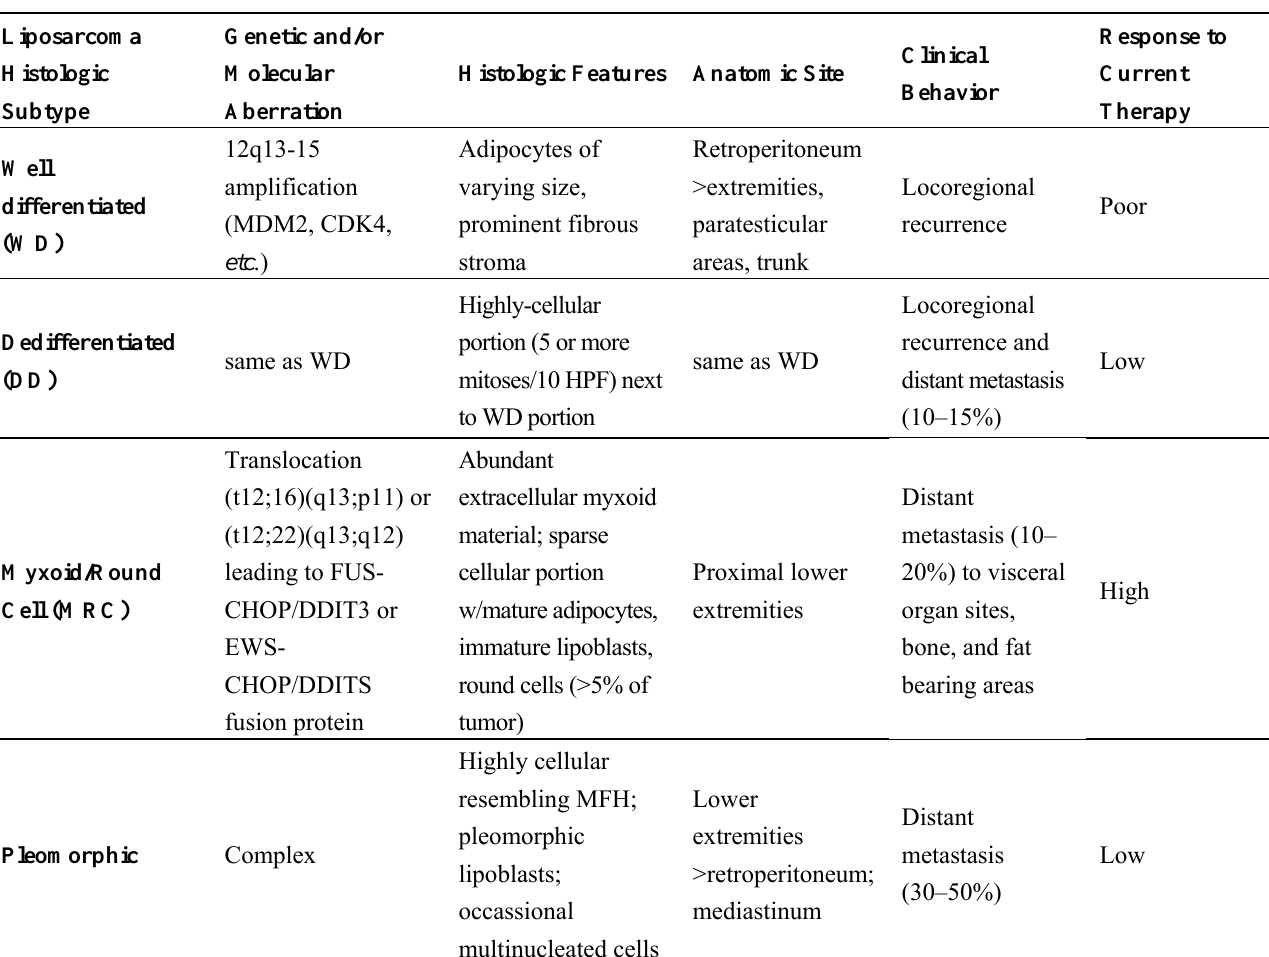
Table 1. Important multi-level differences in liposarcoma